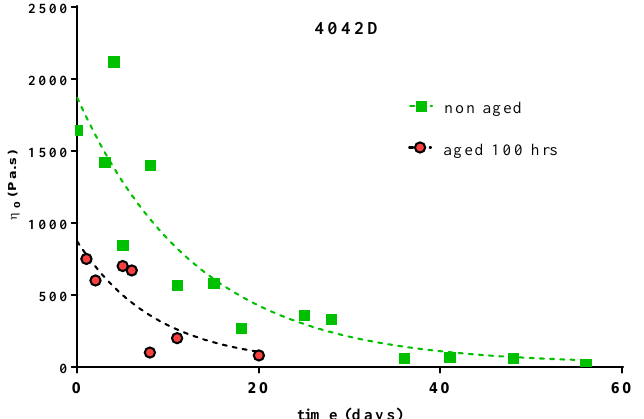
Figure 5. Variation of the Newtonian viscosity versus time of composting for PLA 4042D, 100 h UV aged and non-aged.